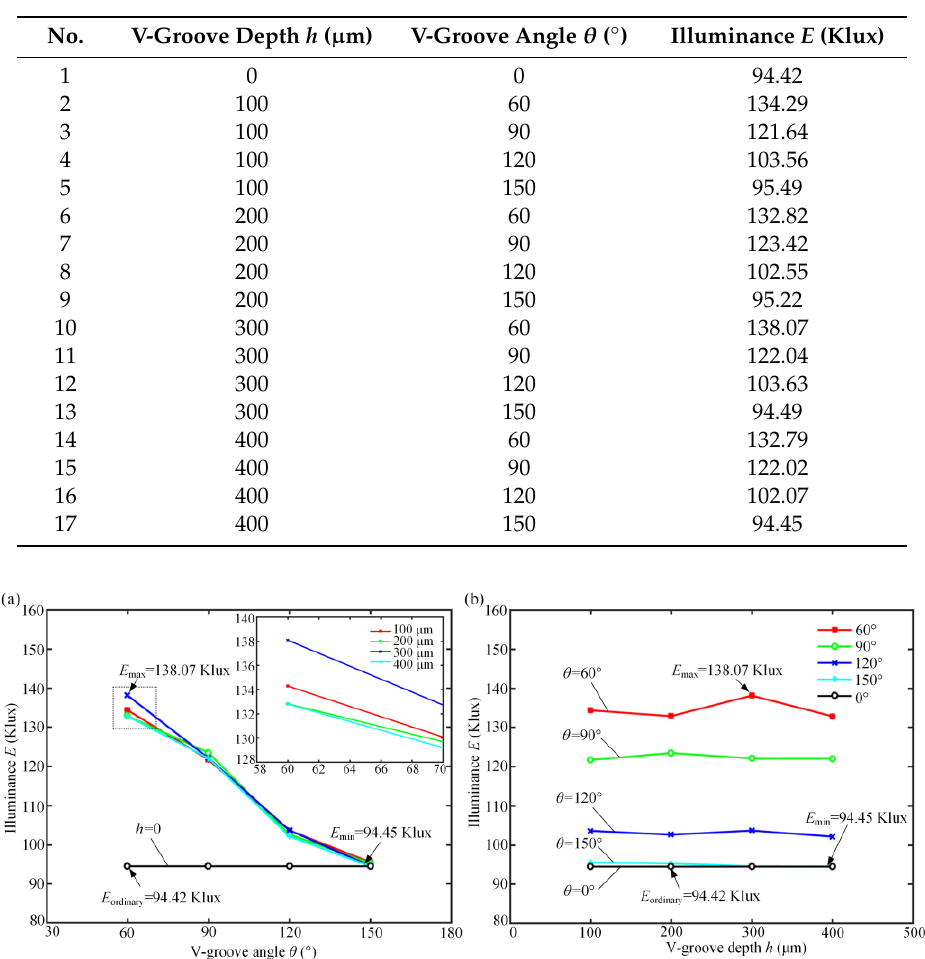
Table 1. Simulated illuminances of LED diffusion plates under different V-groove structure parameters.